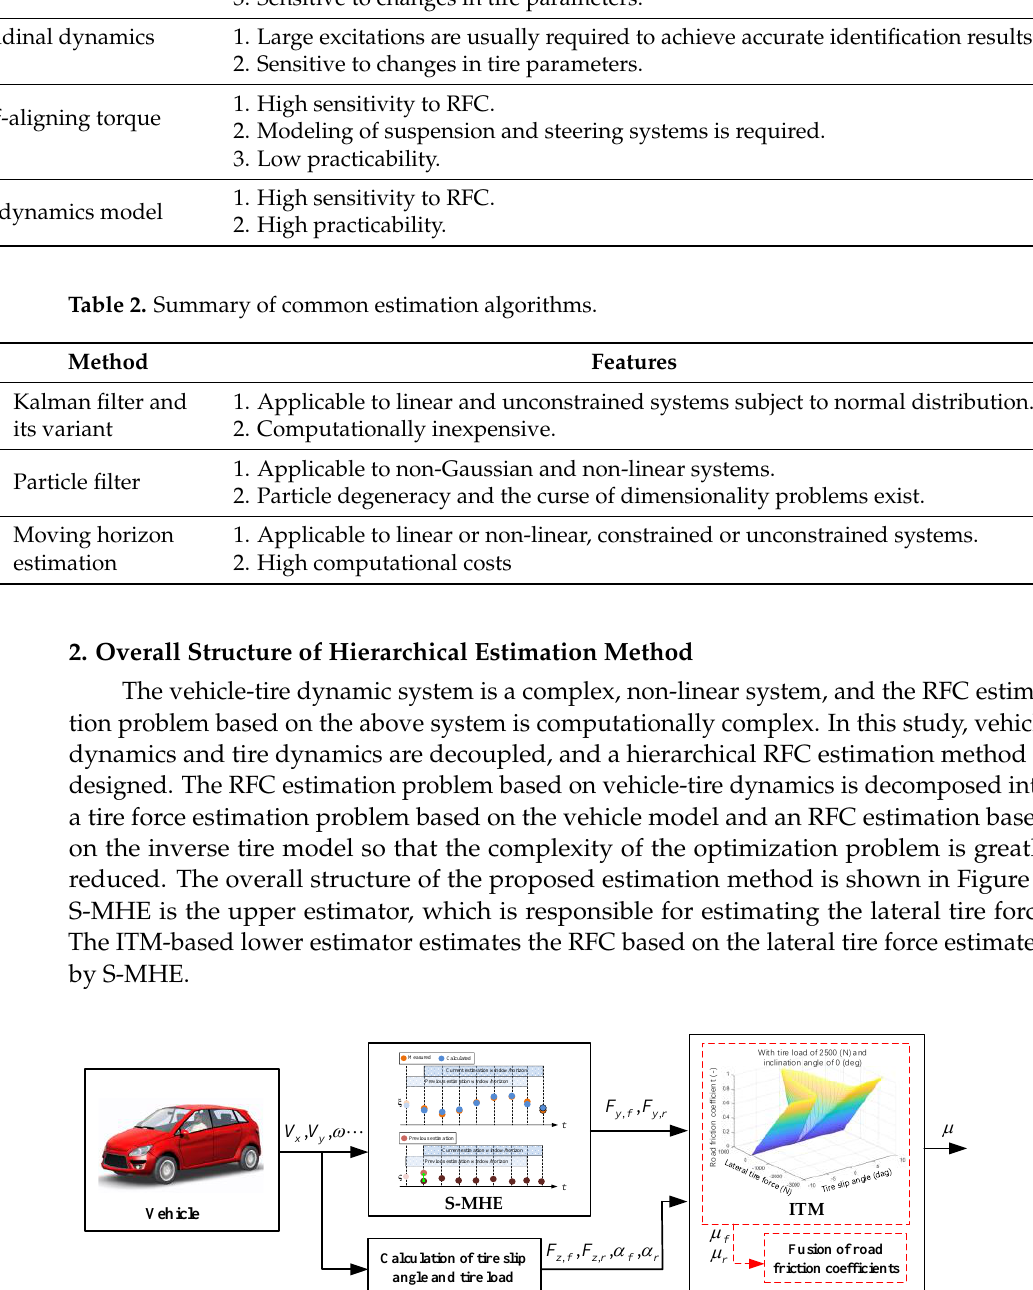
X O Figure 2. Vehicle model. The lateral motion and yaw motion of the vehicle can be described as: ,, ,, cos cos y y a denotes the lateral acceleration. Table 3. Symbols used in the vehicle model. Symbol